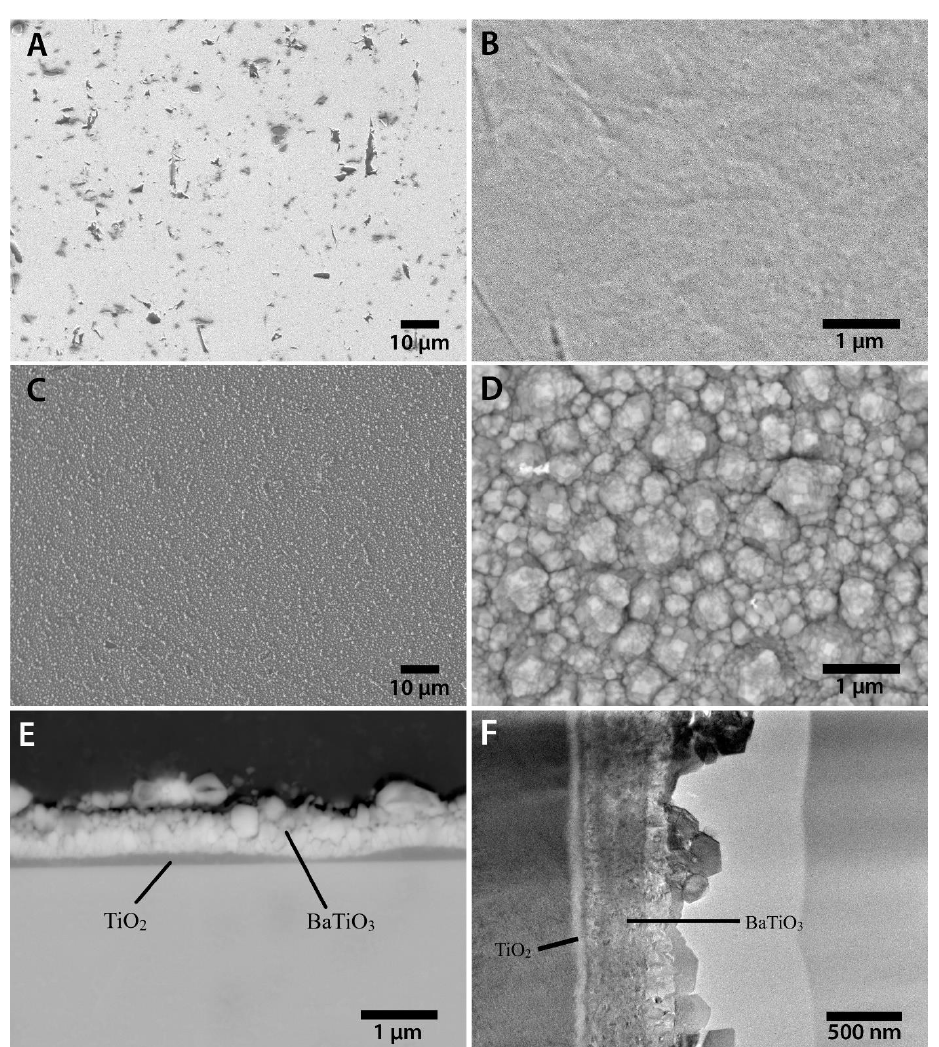
Figure 1. Representative SEM images of surfaces of the Ti39Nb substrate ( A , B ) and of the BaTiO 3 film ( C , D ). The images ( E ) and ( F ) show the cross-section of the BaTiO 3 film. The image ( E ) was obtained by SEM, the continuous BaTiO 3 film is visible and it is possible to identify individual crystals growing from the original TiO 2 layer. The image ( F ) was obtained by TEM and the cross-section of the BaTiO 3 film (rotated perpendicularly) is shown in high resolution. Magnification 1000 × ( A , C ), 20,000 × ( B , D , E ), 50,000 × ( F ). Five samples of each material type were evaluated, and representative images were